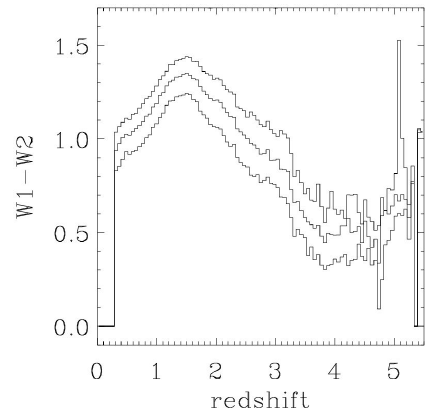
Figure 2. The WISE infrared colors of AGNs. Central line shows averaged color-redshift diagram for selected AGNs; upper and lower lines shows data errors. It can be clearly seen that, for most quasars at z > 3, the W1 − W2 > 0.8 criterion is not met [5].